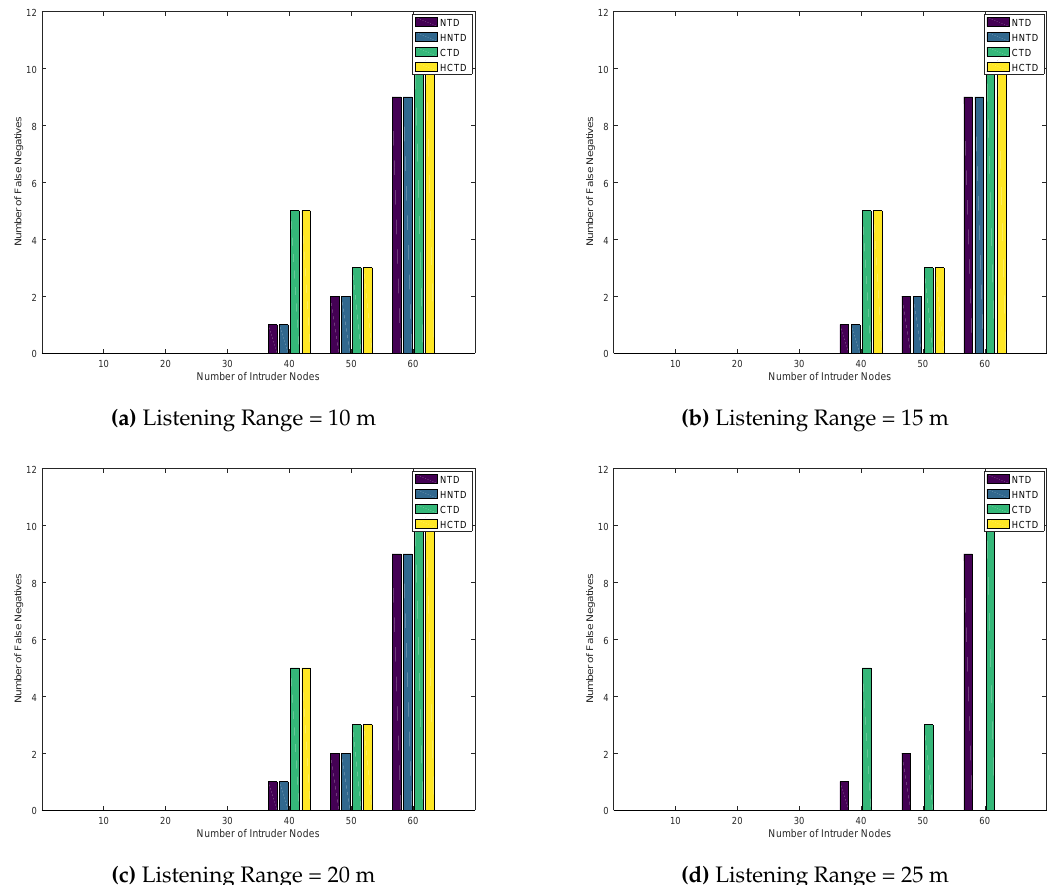
Figure 9. Number of False Negatives for Randomly placed